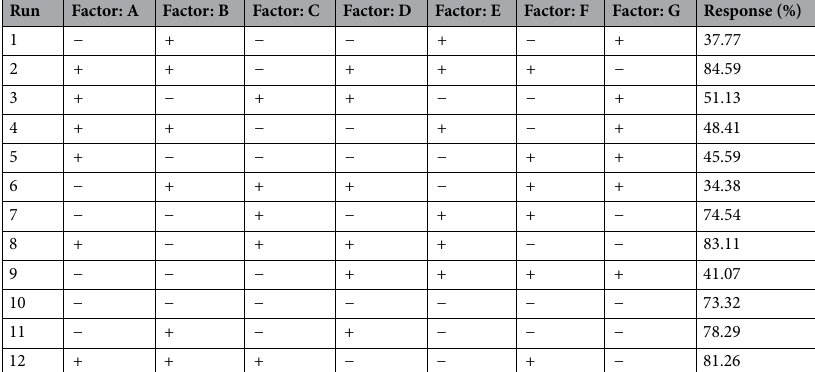
Table 3. PB design and response